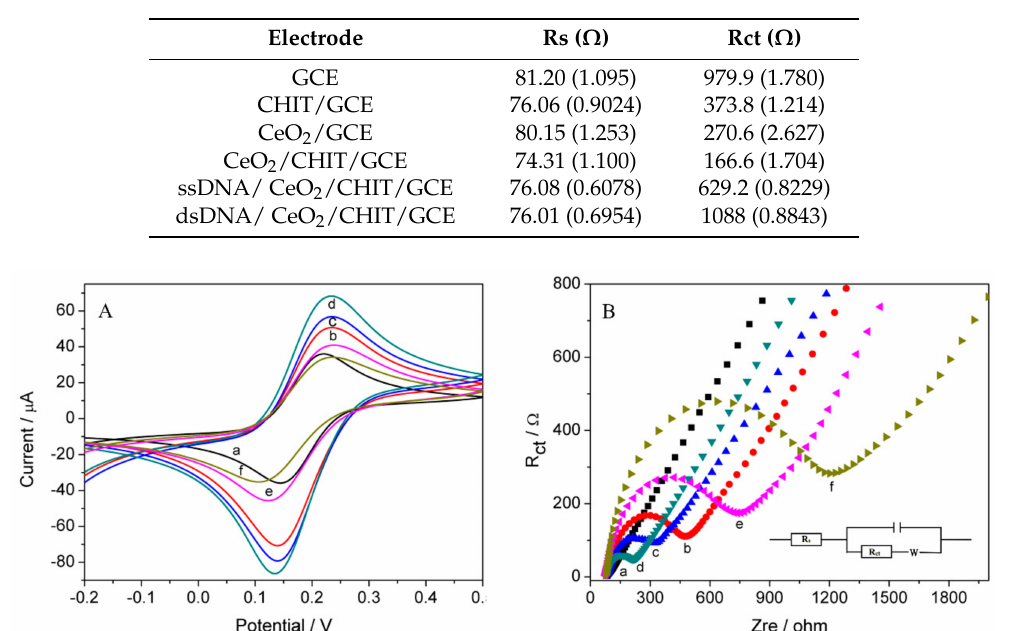
Table 1. Electrochemical parameters of different modified electrodes were obtained using EIS measurements in 0.1 mol/L PBS (pH 7.4) containing 2.0 mmol/L [Fe(CN) 6 ] 3 − /4 − and 0.1 mol/L KCl (vs. SCE).